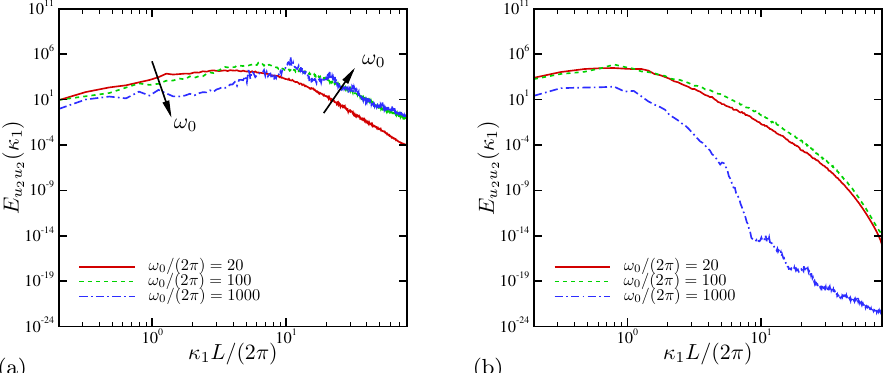
Figure 27. Spatial power spectral density of wall-normal velocity at ( a ) x 2 / L = 0.03 and ( b ) 0.5. The diffusivity ratio is D − / D + =